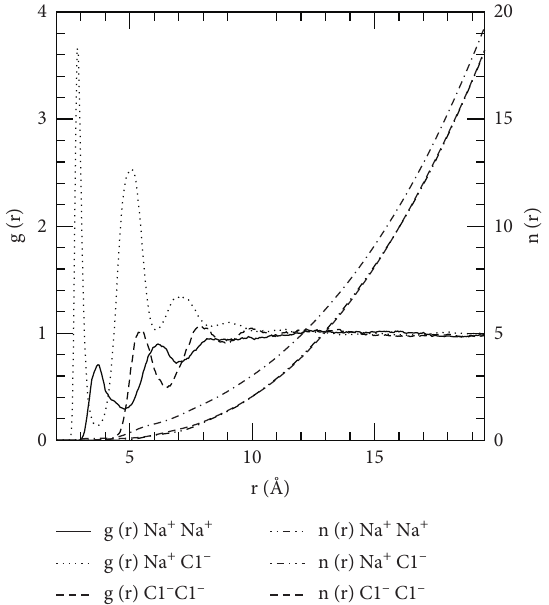
Figure 4: Radial distribution functions gNaNa(r), gNaCl(r), and gClCl(r), and the running coordination numbers, nNaNa(r), nNaCl(r), and nClCl(r) for the A6 MD system at 25 ° C as a function of r (˚A) between the ions (i) using Ewald sum with κ � 0.25 ˚A − 1.